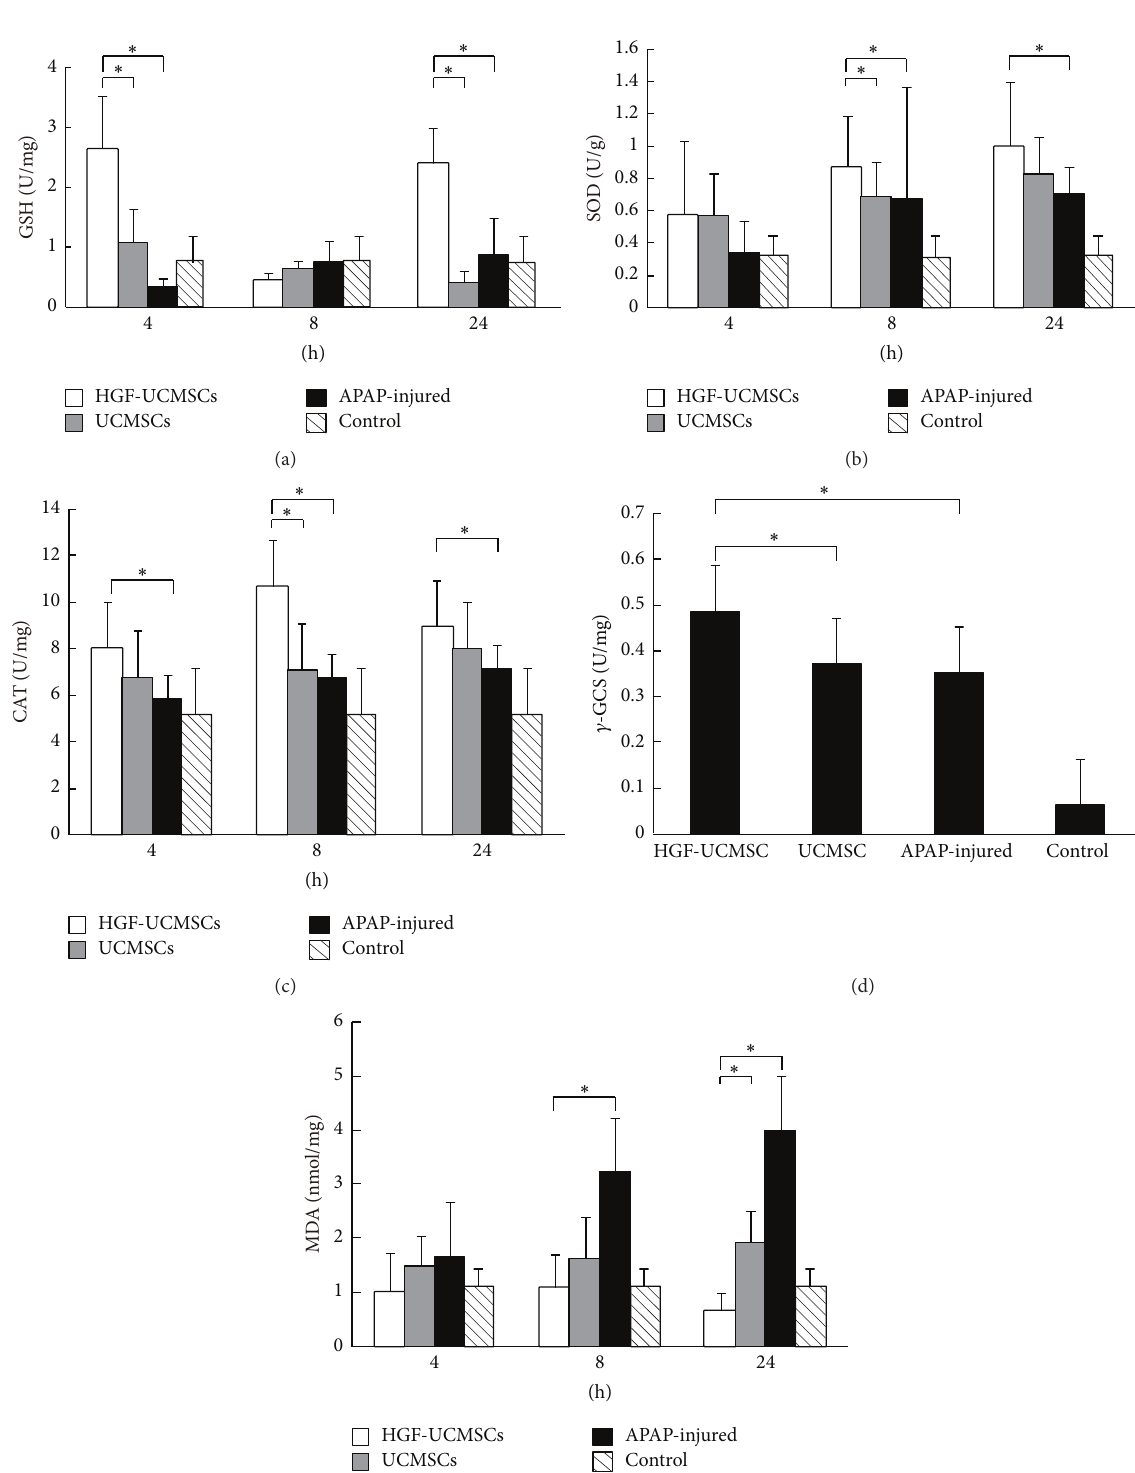
Figure 5: Antioxidant indexes in liver tissue of ALF mice. (a) Level of glutathione. (b) Activity of superoxide dismutase in liver tissue. (c) Activity of catalase in liver tissue. (d) Activity of 𝛾 -glutamylcysteine synthetase ( 𝛾 -GCS). (e) Level of malondialdehyde (MDA). The data are expressed as the means ± SD of three independent experiments. ∗ 𝑃 < 0.5 compared with the